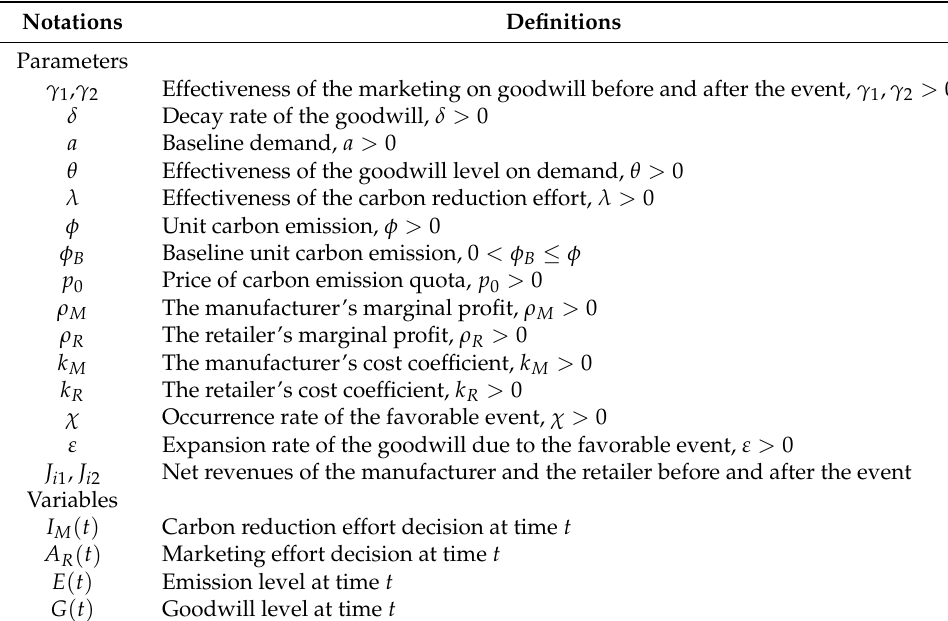
Table 1. Notations and